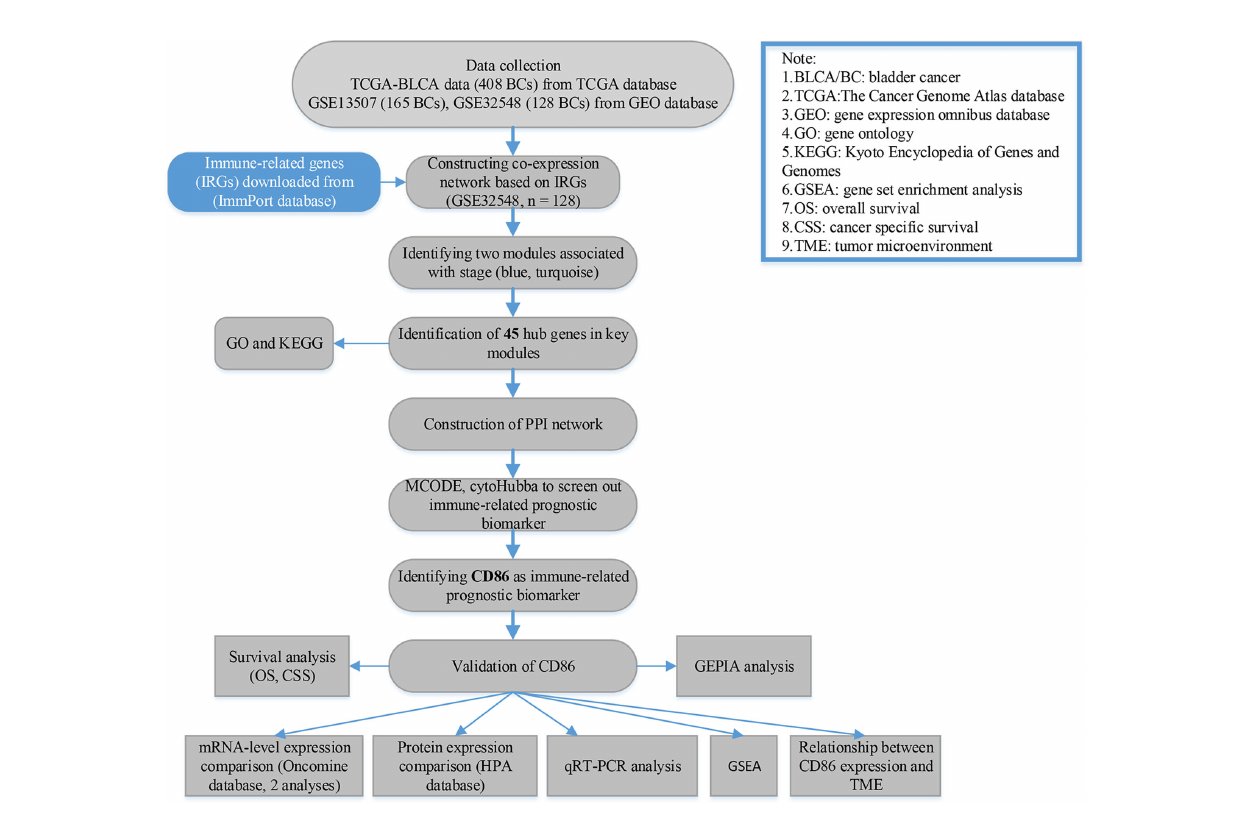
FIGURE 1 | Flow diagram of data preparation, processing, analysis, and validation in this